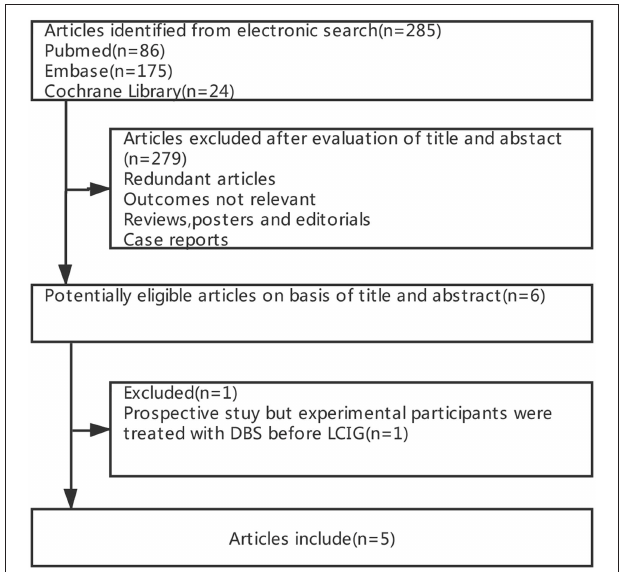
FIGURE 1 | Process of study